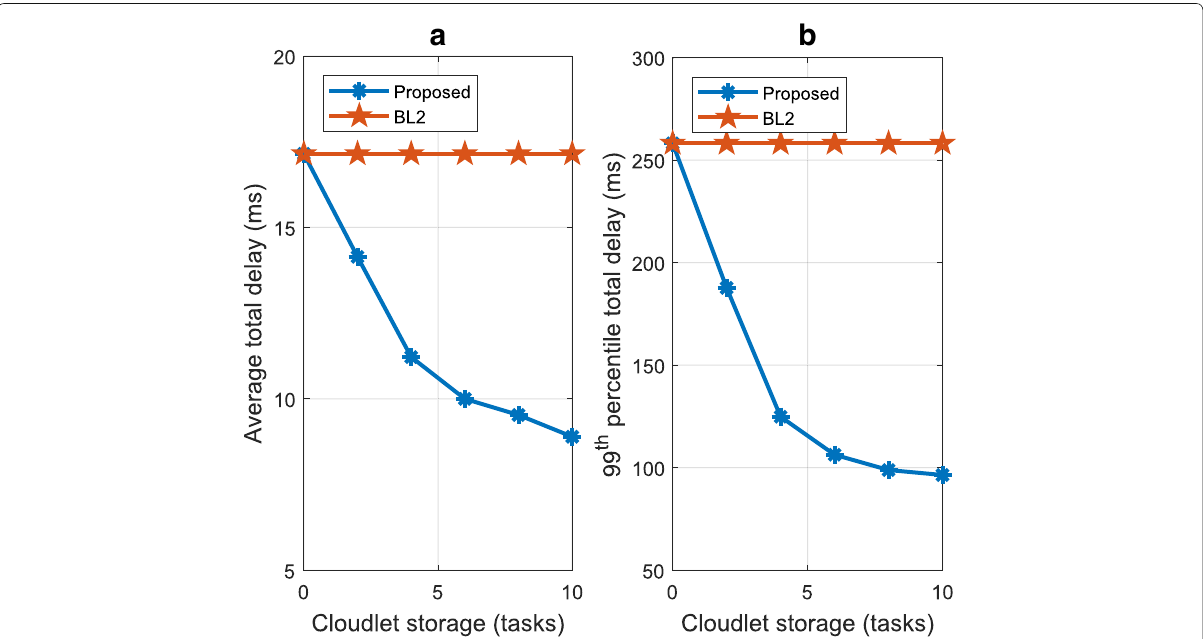
Fig. 5 The delay performance vs. storage size. a The average delay and b the 99th percentile delay performance for different cloudlet storage sizes, with E = 30 cloudlets, and UN density U / E = 3